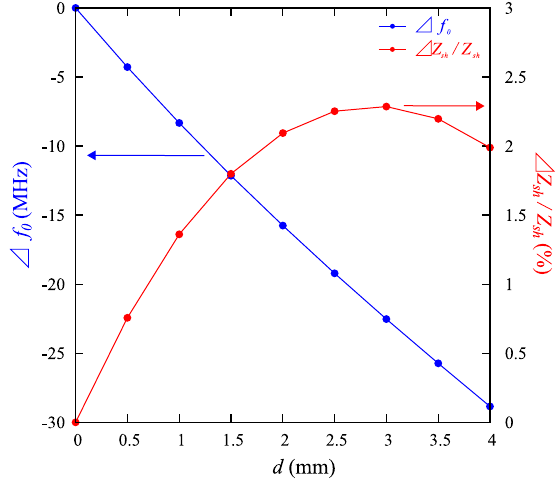
FIG. 3. Shifts of the resonant frequency Δ f 0 and shunt impedance Δ Z as functions of the groove depth d . The shifts sh of resonant frequency are defined as Δ f 0 ¼ f 0 ð d Þ − f 0 ð 0 Þ . The shifts of shunt impedance are defined as Δ Z